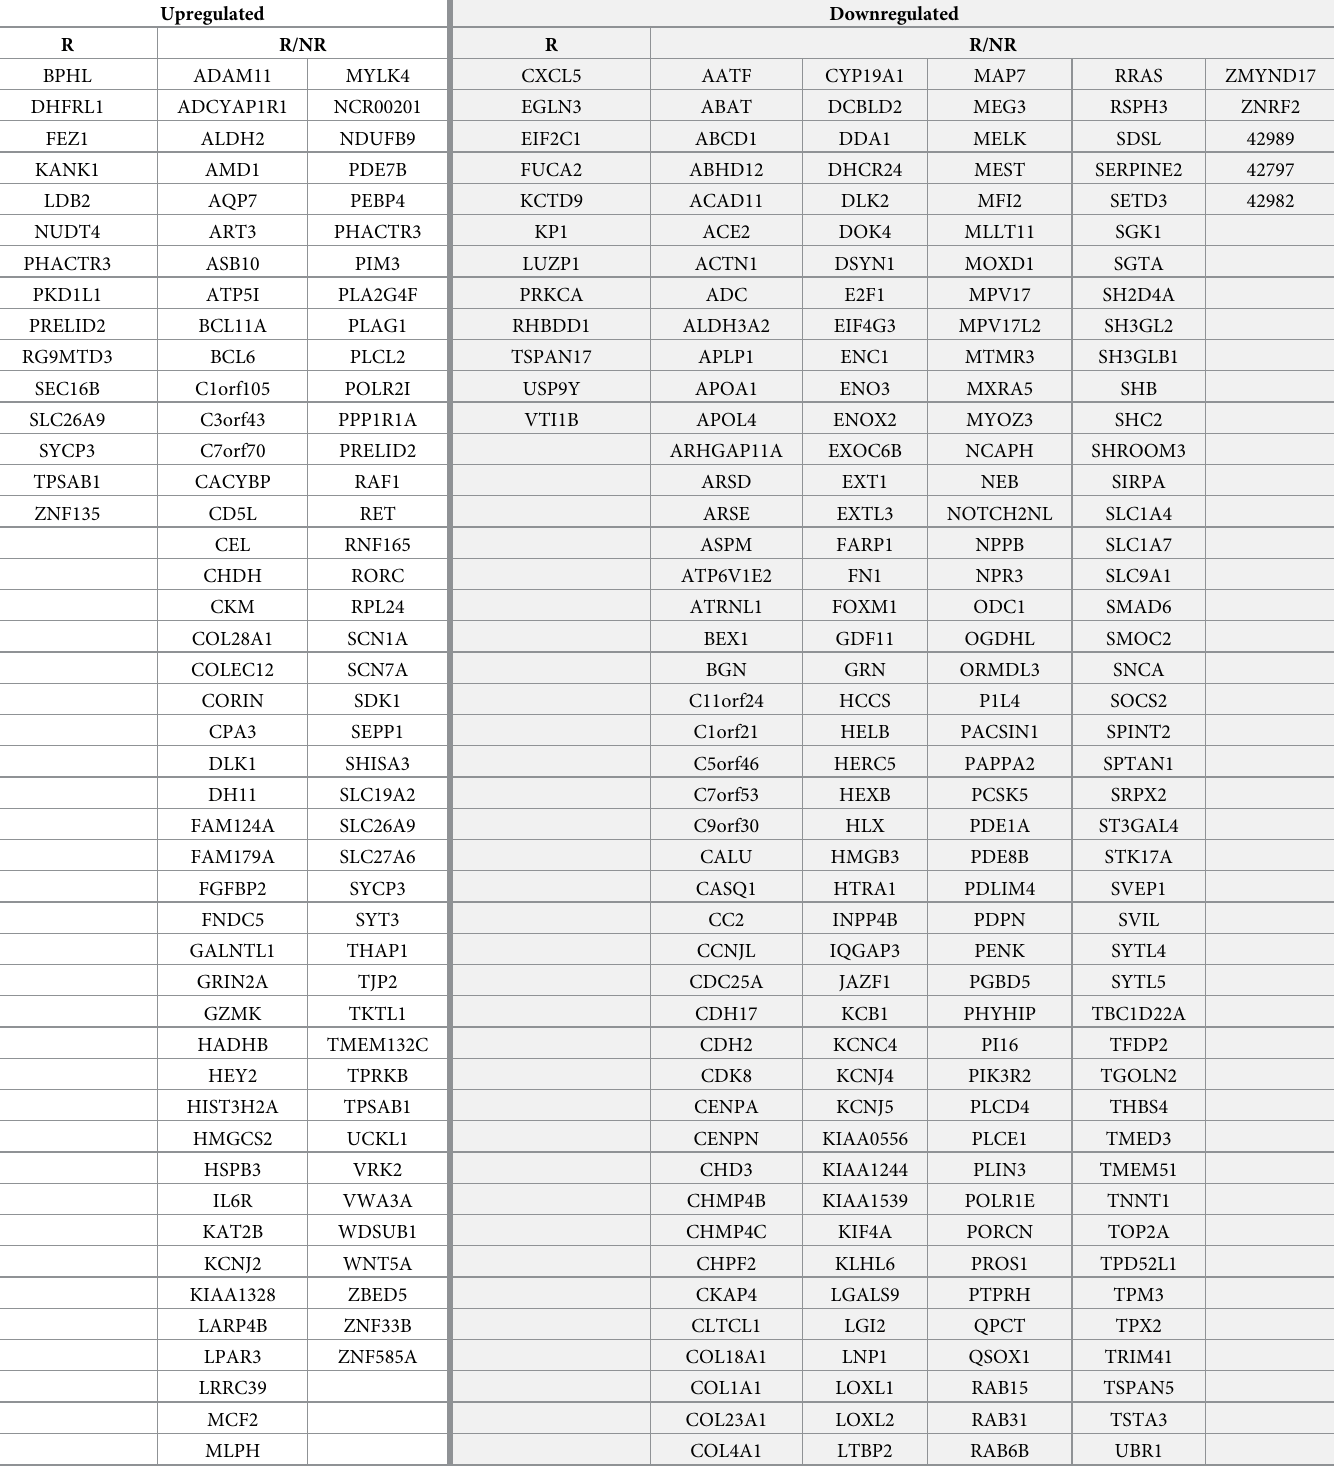
Table 3. Cross-platform concordance of global gene expression changes, mRNA measurements by array and RNA-Seq in the S-R cohort, responder and R/NR data- sets, changes at alpha 0.05.